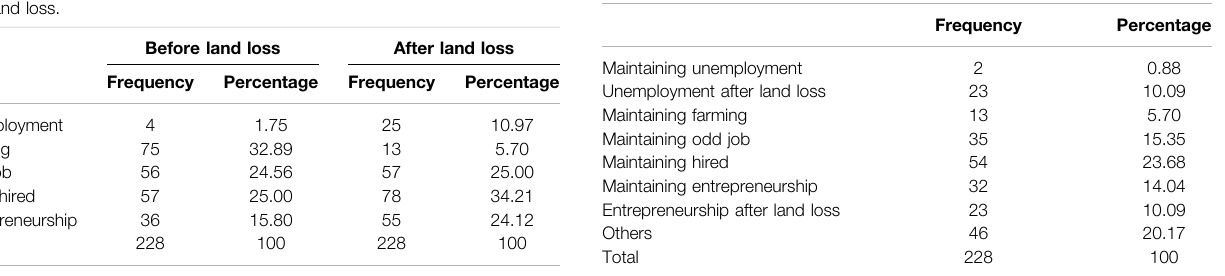
TABLE 4 | Overall changes in employment before and after land